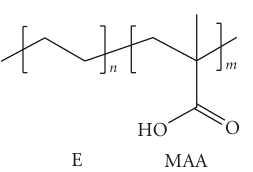
Figure 4: Ethylene-methacrylic acid copolymer